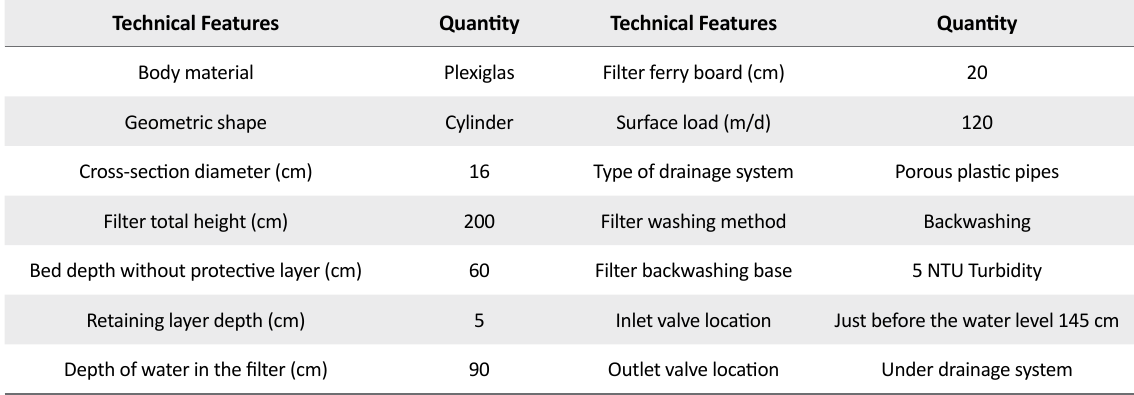
Table 1. Technical features of the pilot used in the research Technical Features